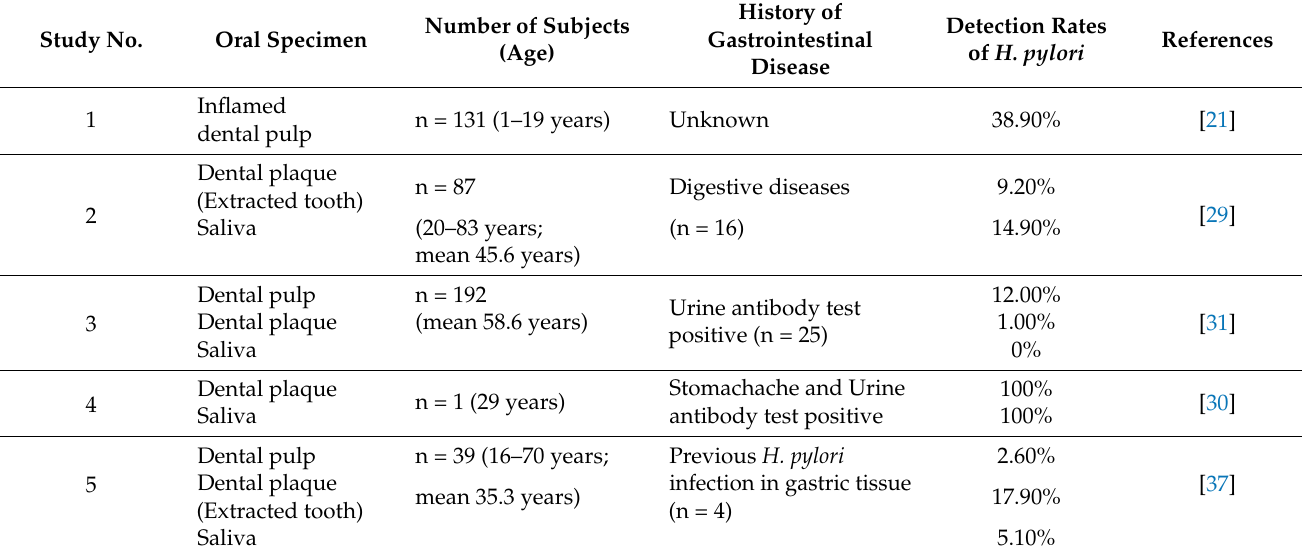
Table 3. Previous studies of H. pylori detected in the oral cavity, by the same nested PCR method as used in this